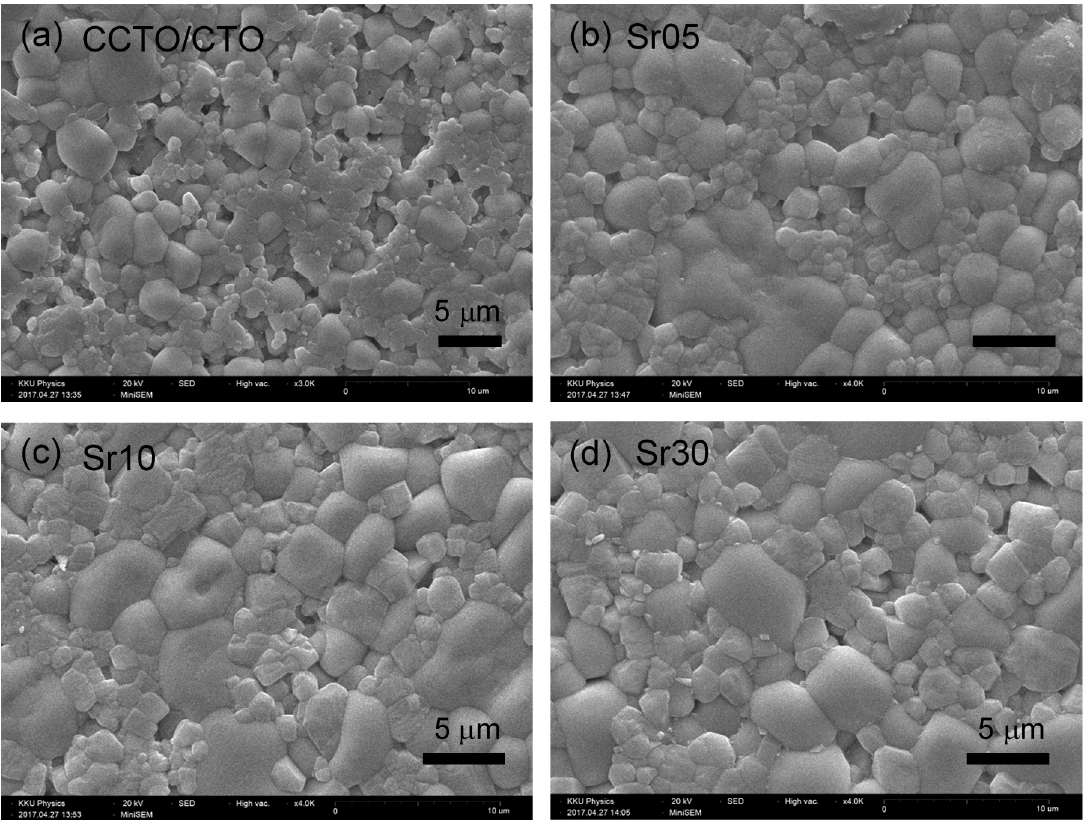
Figure 2. Scanning electron microscopy (SEM) images of Sr2+-doped CaCu 3 Ti 4 O 12 (CCTO)/CTO composites: ( a ) CCTO/CTO, ( b ) Sr05, ( c ) Sr10, and ( d ) Sr30 composite samples.